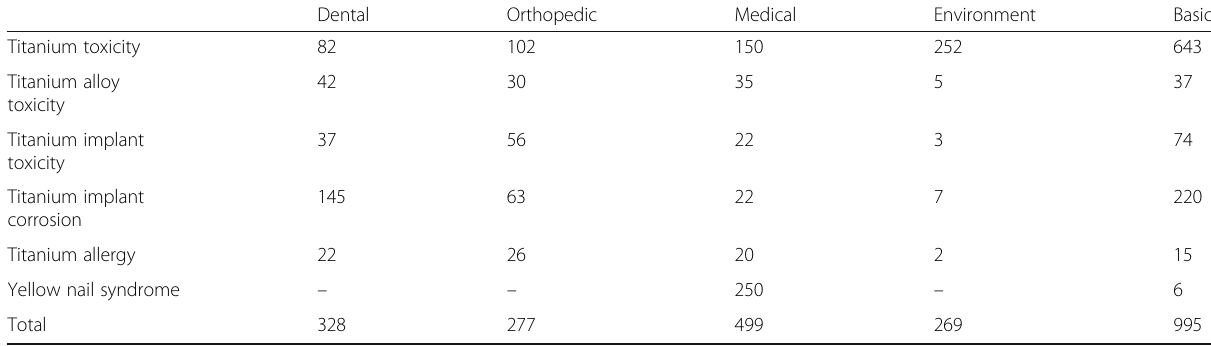
Table 2 Specialized scope of published articles with regard to titanium toxicity